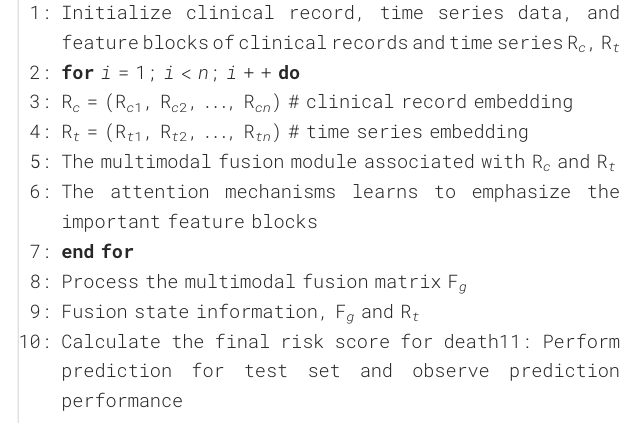
Algorithm 1: The multimodal fusion